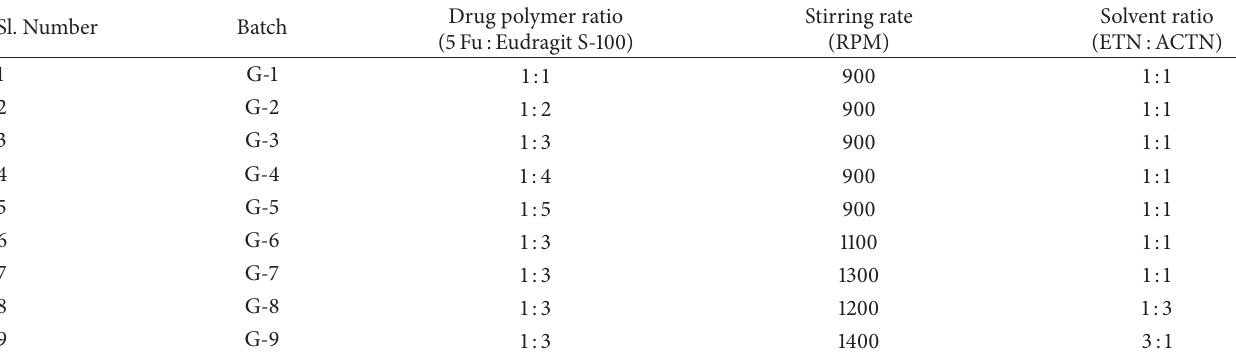
Table 1: Batch specifications for floating hollow microsphres.